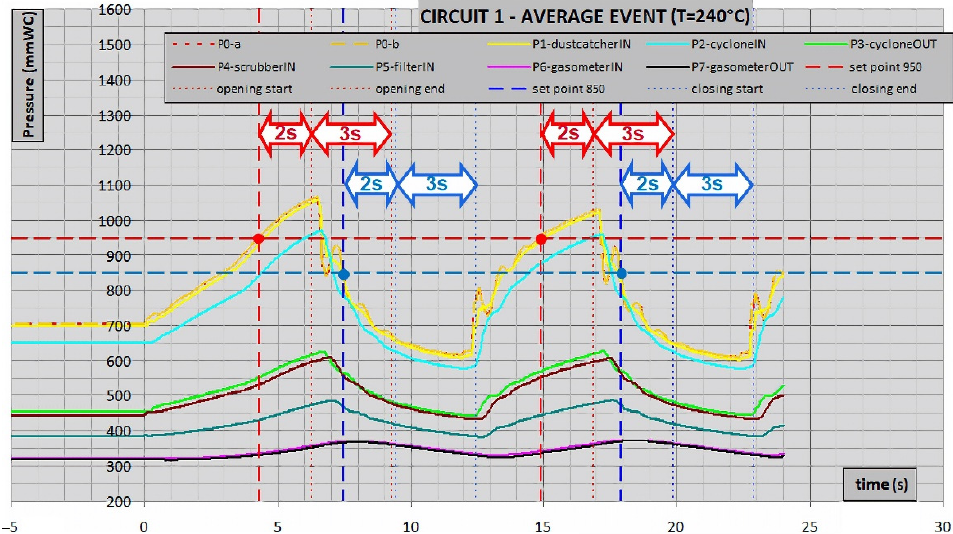
Figure 9. Evolution over time of pressure measures along the circuit C1 in the case of a medium severity event. Time zero is the instant in which the perturbation starts, therefore, during the previous negative time, the model works in nominal conditions.